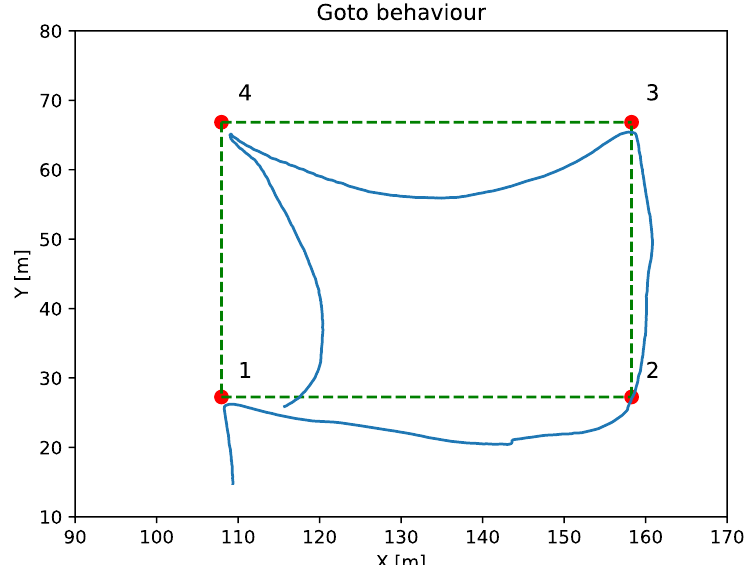
Figure 8. The red dots represent the goto desired waypoints. The blue line represents the vehicle trajectory and the green dashed line represents the ideal navigation route.